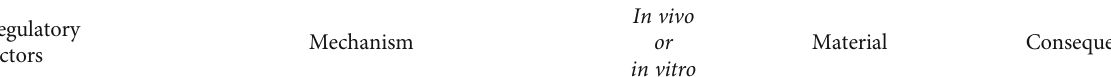
Table 3: Chromatin remodeling in MSC aging and related